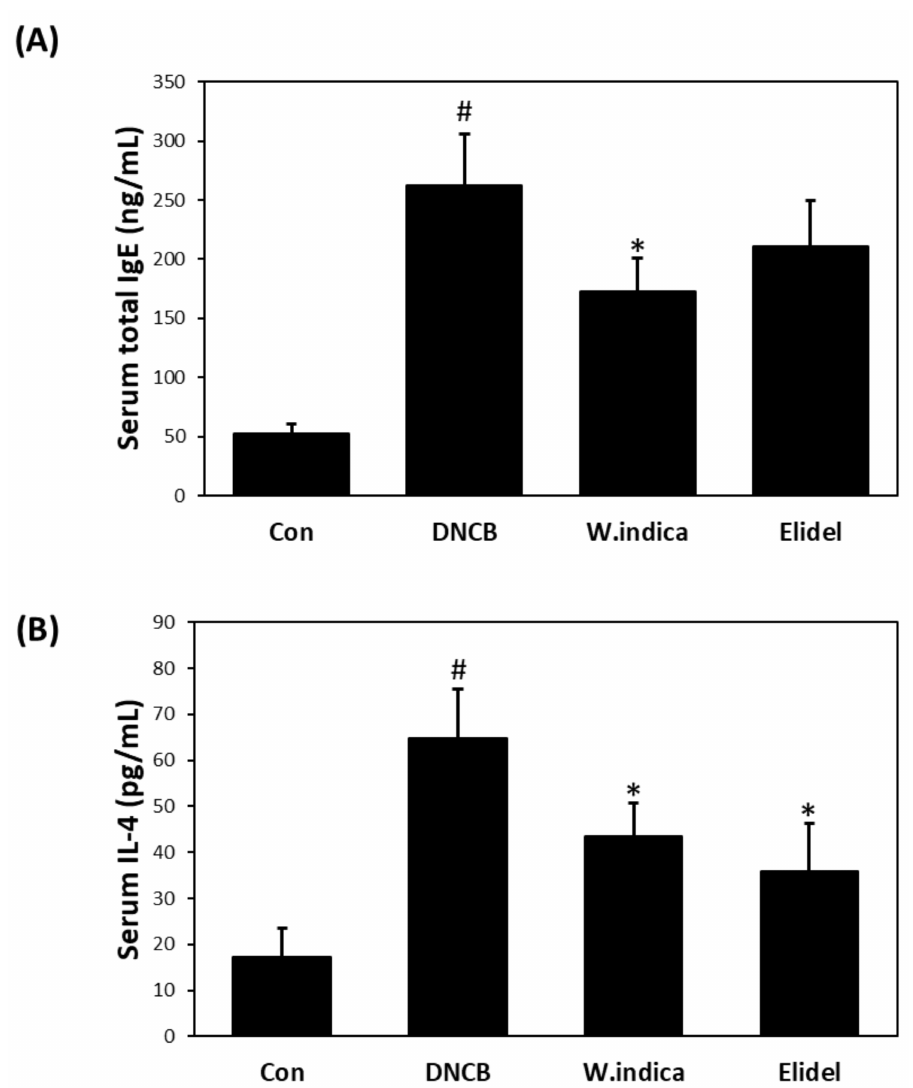
Figure 4. E ff ects of W. indica on serum IgE and IL-4 levels. ( A ) Serum IgE levels. ( B ) Serum IL-4 levels. Results are expressed as the means ± SEMs (n = 7) of two independent experiments. # p < 0.05 vs. the CON group; * p < 0.05 vs. the DNCB group. CON: vehicle control group; DNCB: DNCB + vehicle treated group; DNCB + W. indica : DNCB and 1% W. indica extract treated group; and DNCB + Elidel: DNCB and 1% pimecrolimus treated